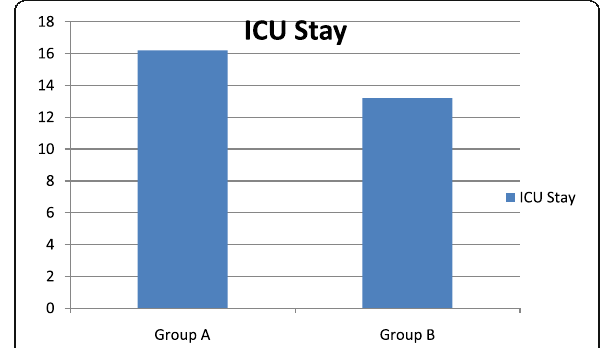
Fig. 7 Bar chart showing the comparison between group A (control) and group B (esmolol) according to ICU stay